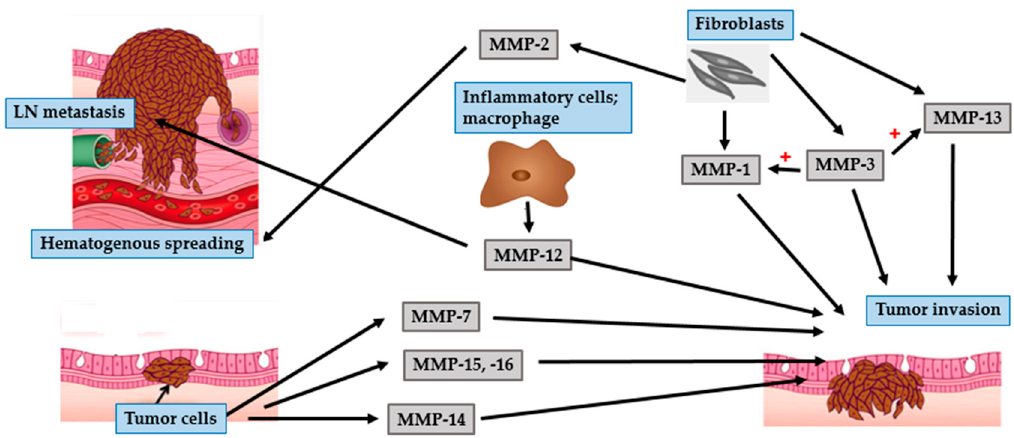
Figure 7. Role of MMPs in malignant melanoma tumor metastasis. Fibroblasts secrete MMP-1, MMP-3 (also activate MMP-1 and MMP-13) and MMP-13 to facilitate tumor invasion. Melanoma cells secrete MMP-7, MMP-14, MMP-15, and MMP-16 and facilitates tumor invasion. Inflammatory cells secrete MMP-12 to promote tumor invasion and are involved in lymph node (LN) metastasis. Fibroblasts-derived MMP-2 correlates with hematogenous spreading.